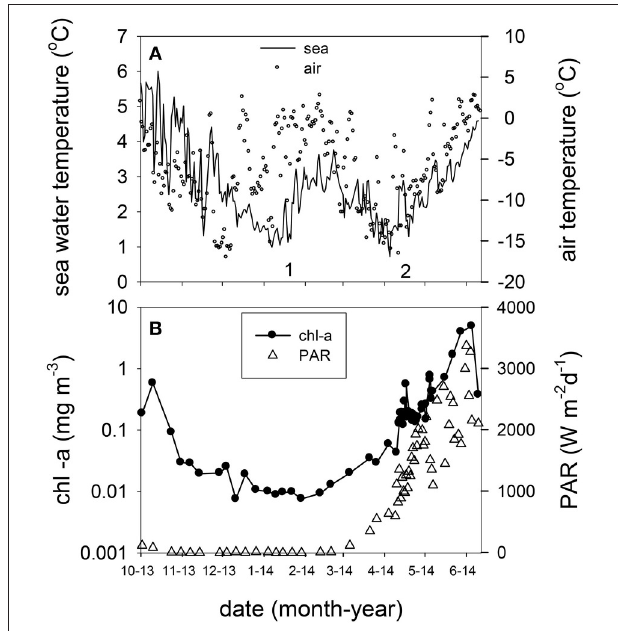
FIGURE 2 | (A) Daily averaged sea water temperature at the ferry box inlet (11m) from October 2013 to June 2014 (left y axis) and air temperature in Ny Ålesund at 2m. The numbers 1 and 2 indicate Atlantic advection events. (B) Ferry box chlorophyll-a concentration and daily PAR dose